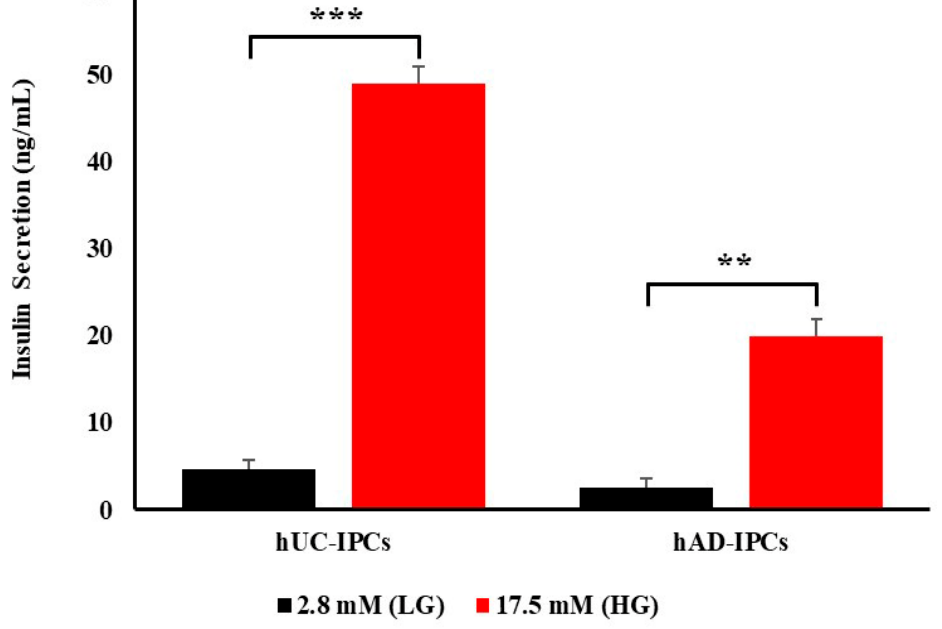
Figure 4. Insulin secretion from pancreatic islets in hUC-IPCs and hAD-IPCs, as evaluated using the GSIS test. Low- (2.8 mM) and high-glucose (17.5 mM) conditions were used to stimulate hUC-IPCs and hAD-IPCs. Insulin secretion was quantitatively measured using insulin enzyme-linked im-